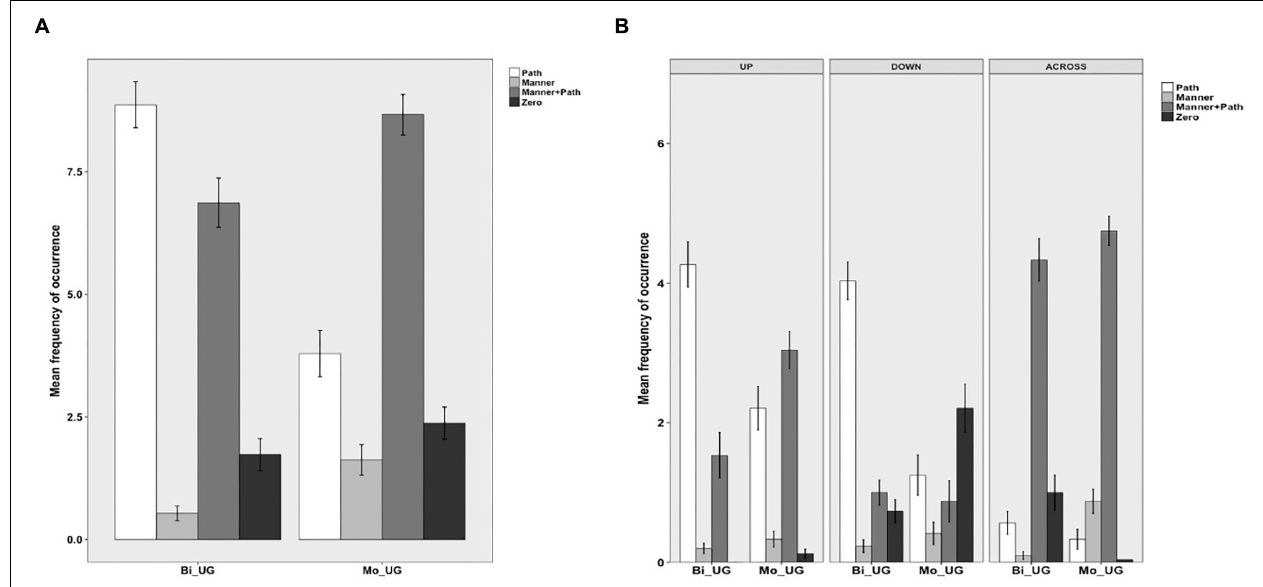
FIGURE 3 | Information in the OTHER locus in